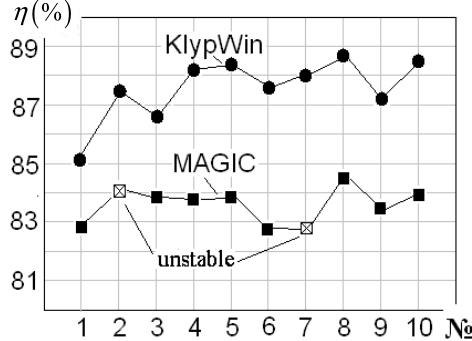
Figure 5. Results of COM-klystron modeling by codes KlypWin and MAGIC.